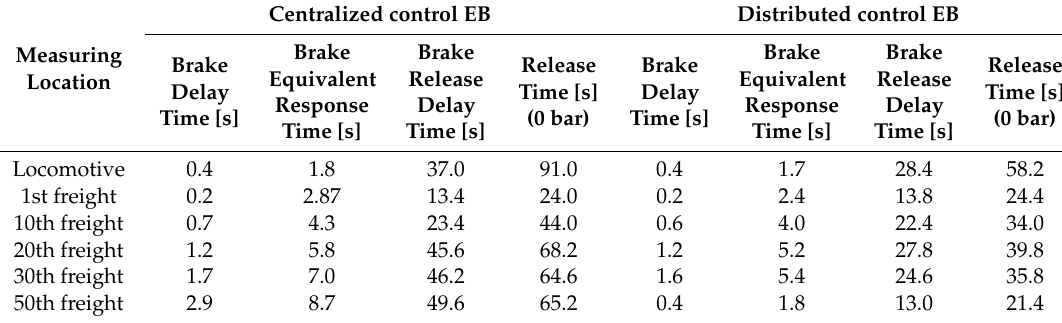
Table A3. Emergency braking results